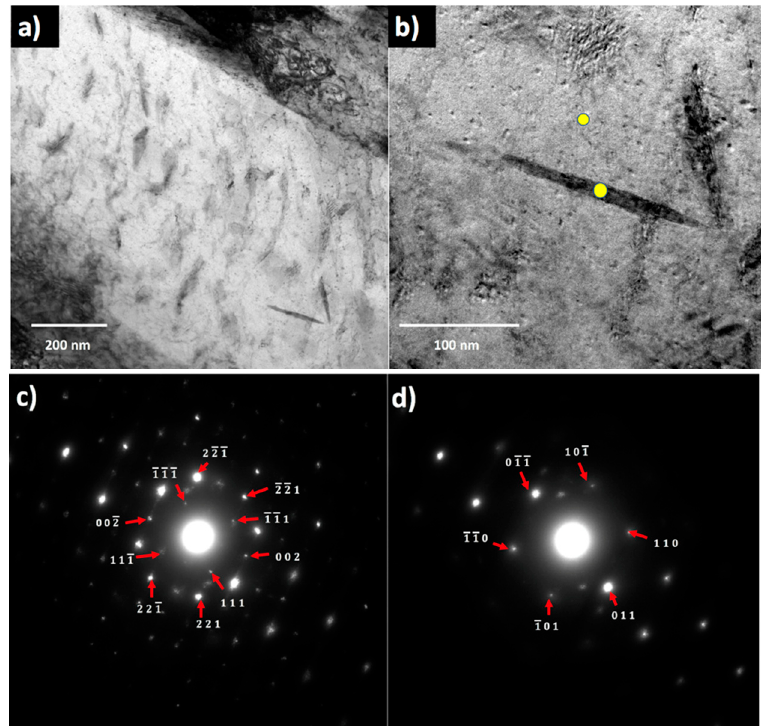
Figure 3. Transmission and Scanning transmission electron microscopy (TEM/STEM) micrographs of hot-mounted specimens austenitized and quenched in the Gleeble. ( a ) STEM image of cementite precipitates in a coarse martensite lath; ( b ) TEM image of cementite precipitate, where yellow dots mark the location of nanobeam selected area diffraction (NB-SAD) patterns; ( c ) NB-SAD pattern with cementite diffraction spots indexed, zone axis [110]; ( d ) NB-SAD pattern with ferrite matrix spots indexed, zone axis close to [111].